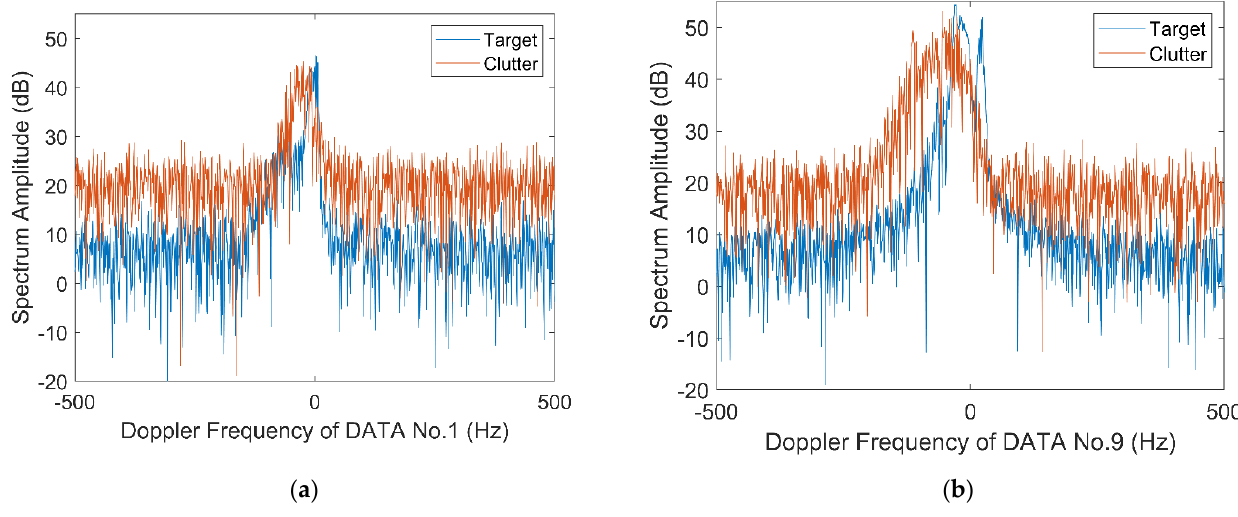
Figure 5. Frequency spectrogram of sea clutter and target signals from different echoes. ( a ) is the spectrogram of data names